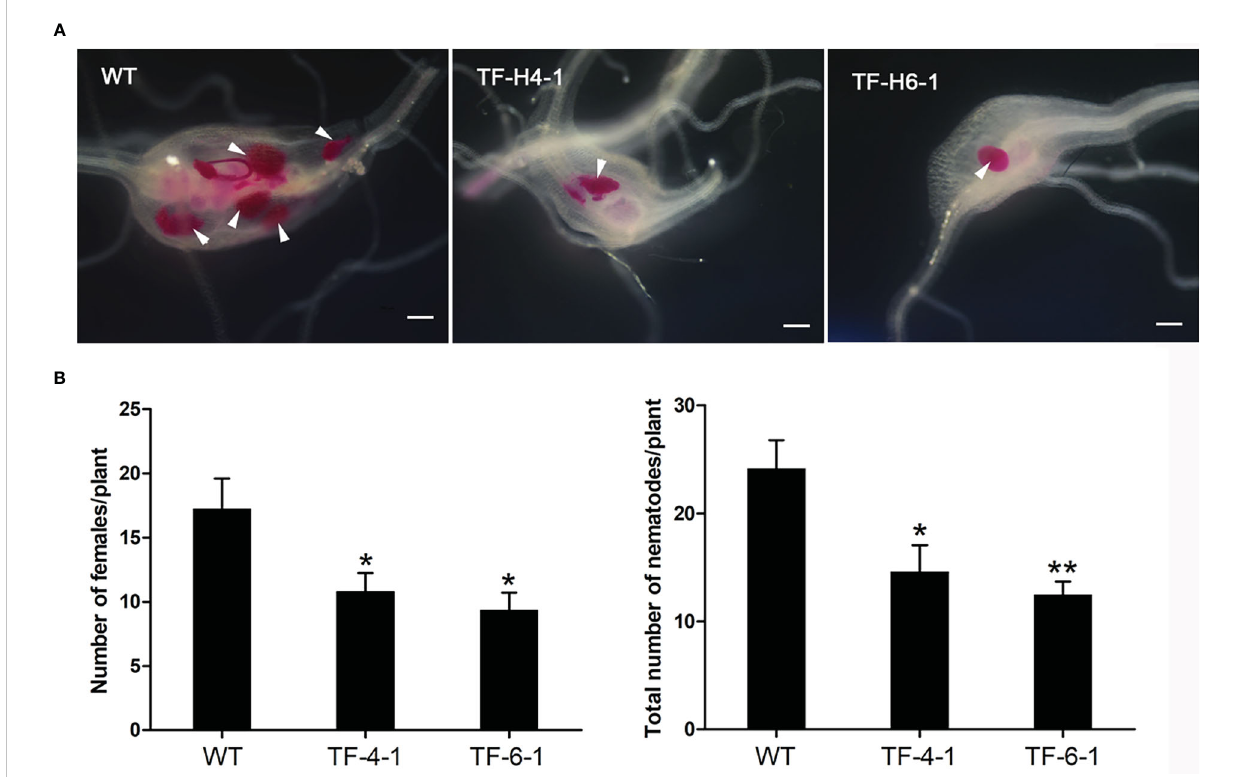
FIGURE 3 CRISPR/Cas9-mediated OsHPP04 mutants exhibited enhanced rice resistance to Meloidogyne graminicola . (A) Representative pictures of galls in wild-type (WT) and two ‘ transgene-free ’ edited plants (TF-H4-1 and TF-H6-1) at 12 day post-inoculation (dpi) with M. graminicola . The white arrows indicate nematodes. Bars = 200 m m. (B) The number of adult females and nematodes in indicated rice lines at 12 dpi with M. graminicola . Data were analyzed by a two-tailed Student ’ s t-test (* P < 0.05, ** P < 0.01. Values are mean ± SE